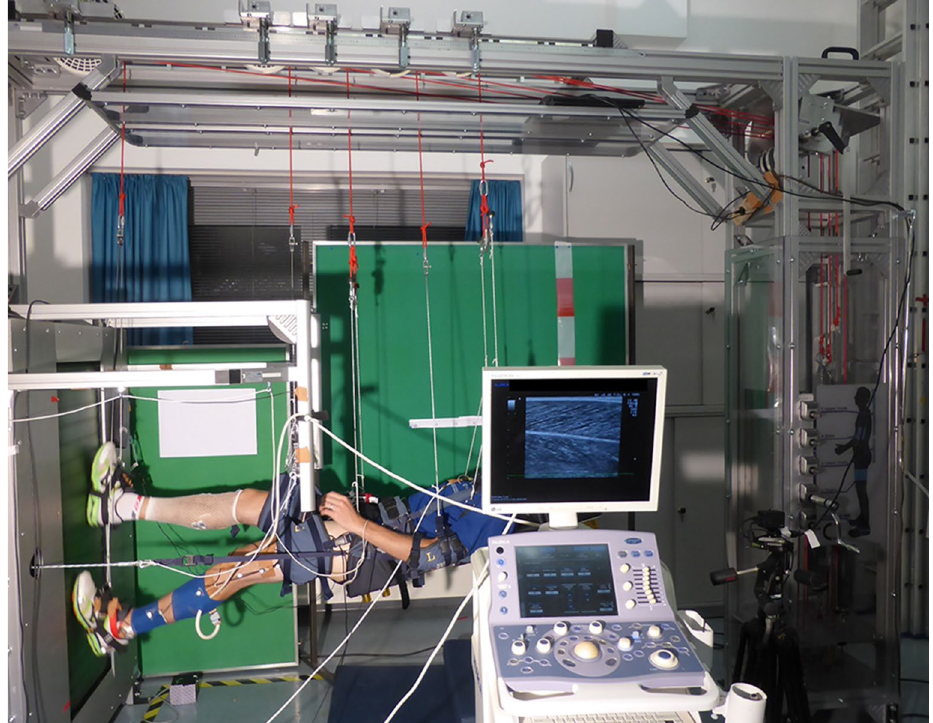
Figure 3. VTF Experimental set-up. Participant being suspended horizontally on the vertical treadmill facility (VTF) with an ultrasound transducer attached to the midbelly of the GM muscle and electrogoniometers placed over the knee and ankle joint to record the respective joint angles. Photo credit: Charlotte Richter; informed consent was obtained to publish this